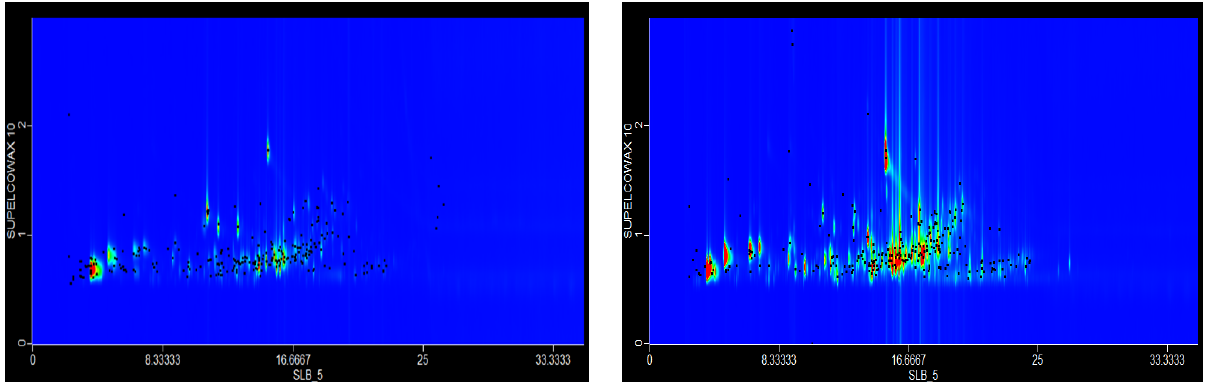
Figure 3. Chromatograms of Artemisia alba L. ( Left ) and Achillea millifolium L. ( Right ) obtained by SPME-GCxGCToFMS and used in cosmetic formulae. The remaining chromatograms of plants analyzed are provided in Supplementary Materials (Figure S2A–I).